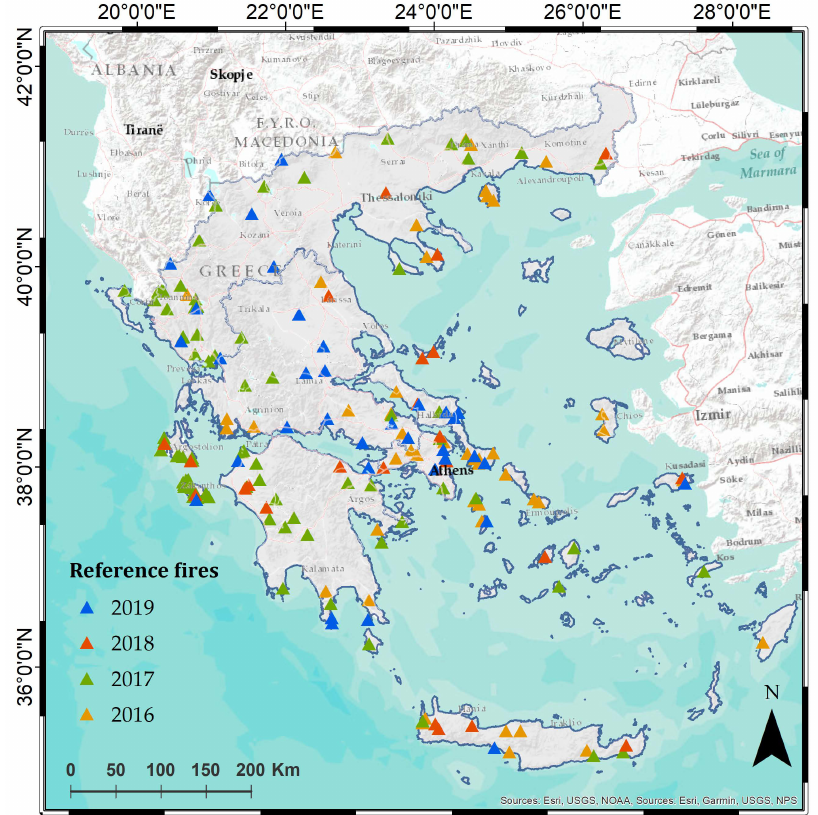
Figure 1. The study area is the country of Greece. The colored triangles show the reference fire locations, determined by Sentinel-2 images. (Basemap sources: Esri, Garmin, USGS, NOAA, NPS). Fires constitute one of the major disturbances of Greek forests and wildland areas, with most fires being induced directly or indirectly by human activity and occurring in